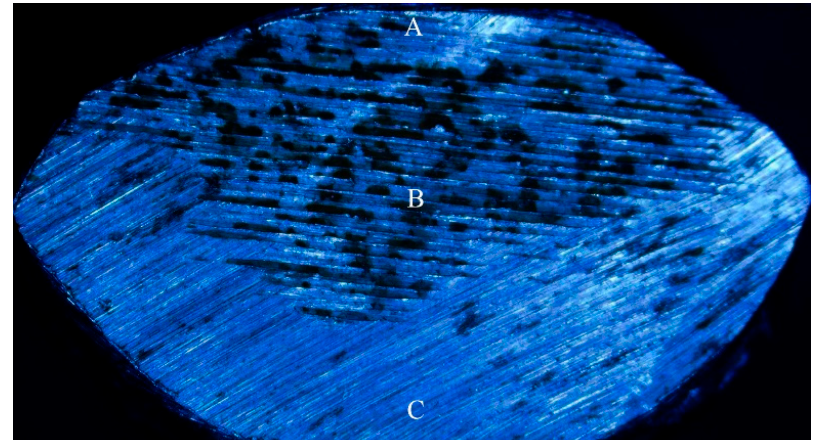
Figure 7. A-B-C. Figure 7. A-B-C.